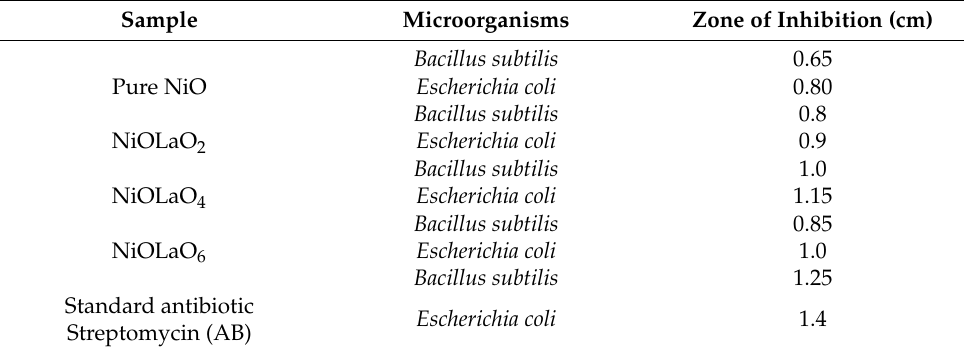
Table 1. Antibacterial activity of La 3+ ion-doped Nio nanoparticles.